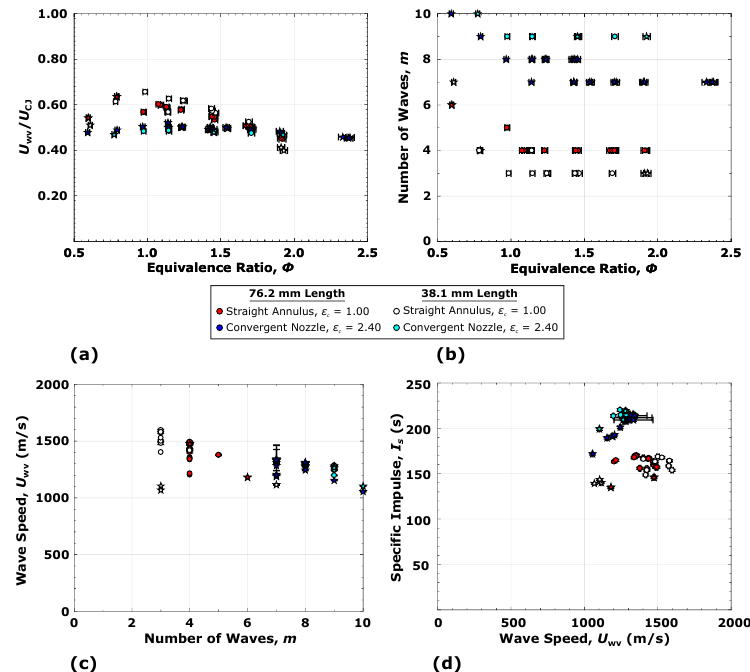
Figure 18. Summary of the detonation mode characteristics for the equivalence ratio conditions at ˙ m tot = 0.272 kg/s, depicting the ( a ) wave speed percentage of ideal and ( b ) number of waves m , as well as the wave speed sensitivity to the ( c ) number of waves and ( d ) specific impulse I s . Depending on the flow condition and convergent nozzle geometry, the engine operates in either a corotating ( • ) or counter-propagating mode ( (cid:63) ).